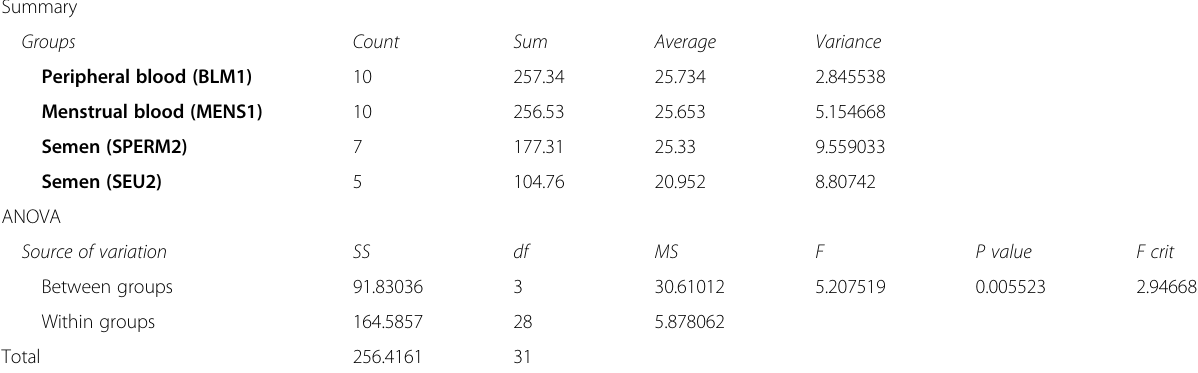
Table 2 ANOVA of results of amplification of the four body fluid-specific DNA methylation markers in different body fluids Summary